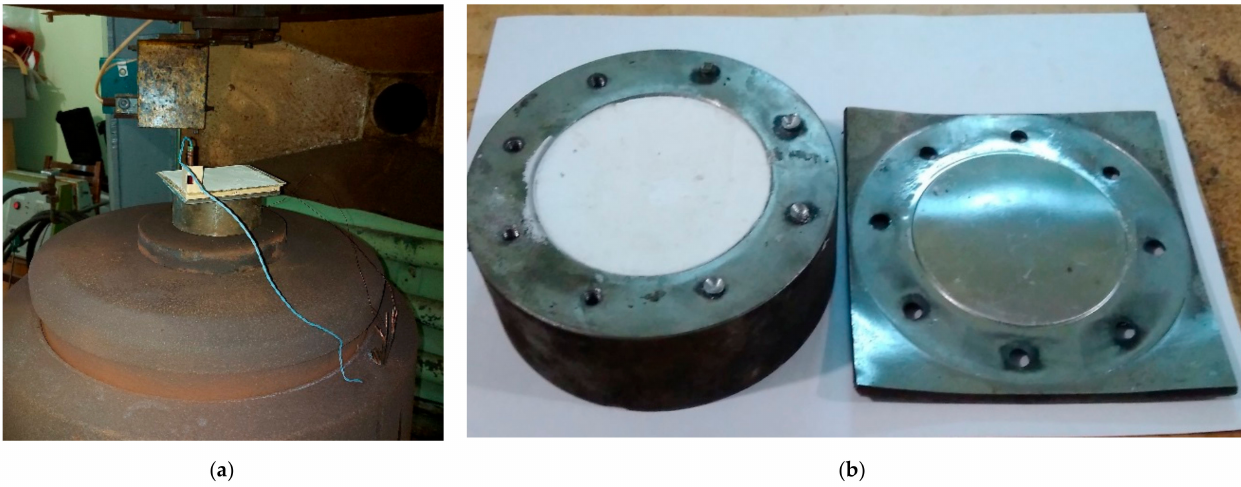
Figure 5. Powder activation by explosive loading: ( a ) experimental assembly mounted on the table of an explosion chamber with HE charge on top; ( b ) mold with treated powder after removing the steel